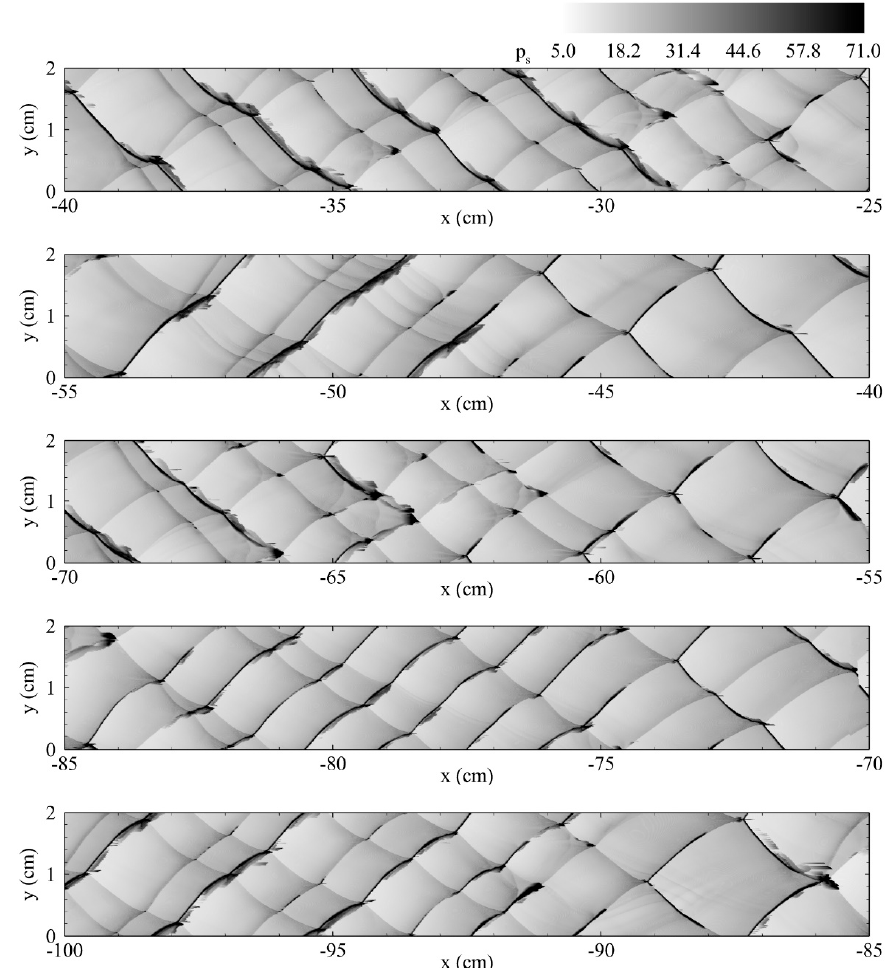
Figure 8. Numerical smoked foil record for H 2 + O 2 mixture.